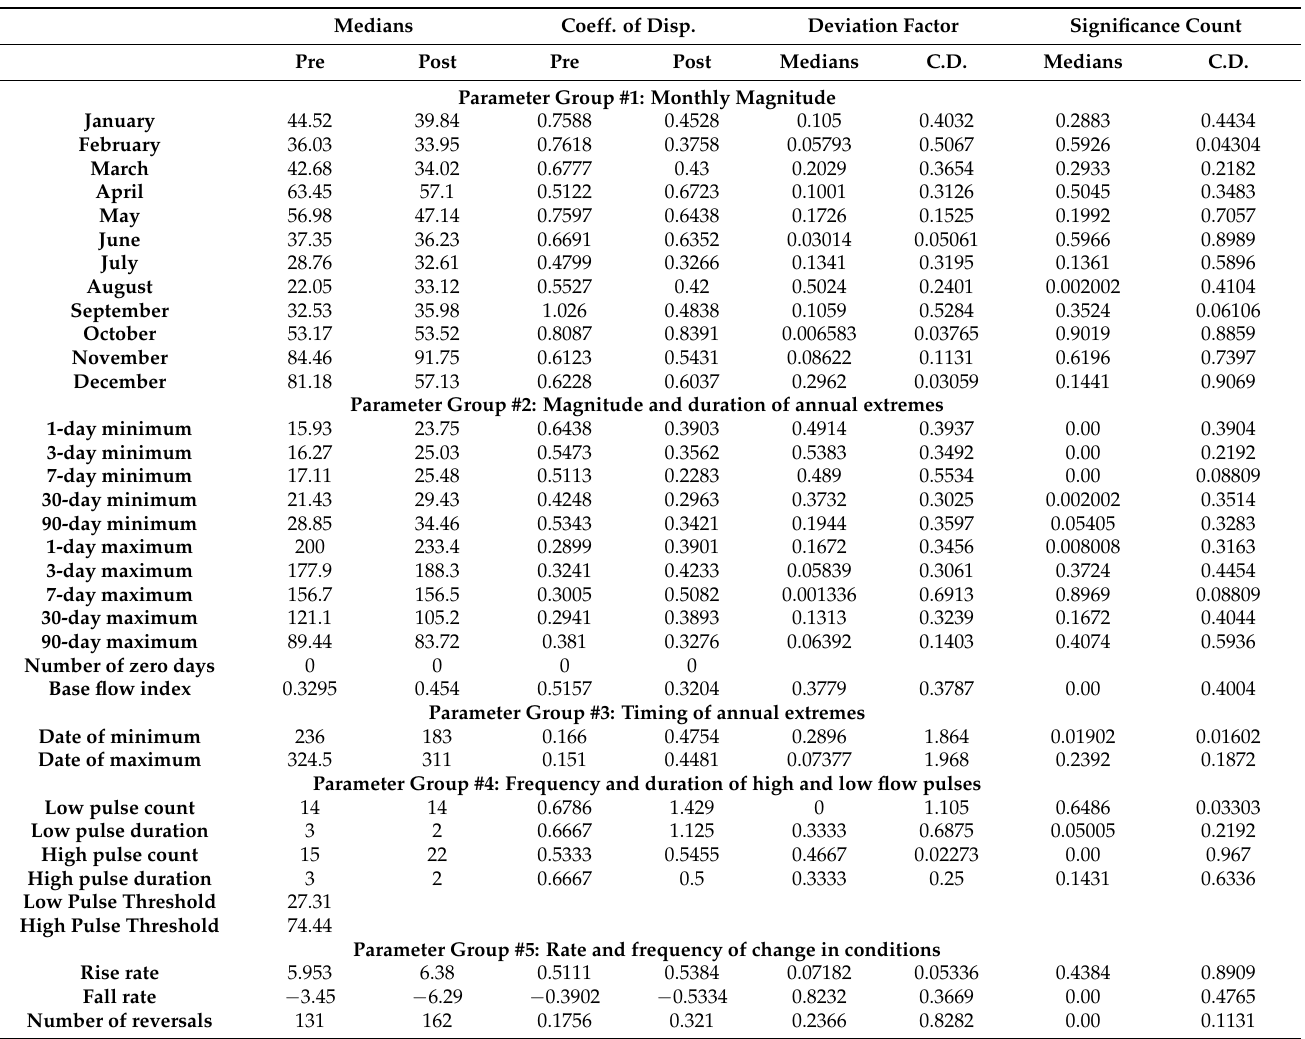
Table 4. Scorecard table of IHA analysis at Selangor River. Medians Coeff. of